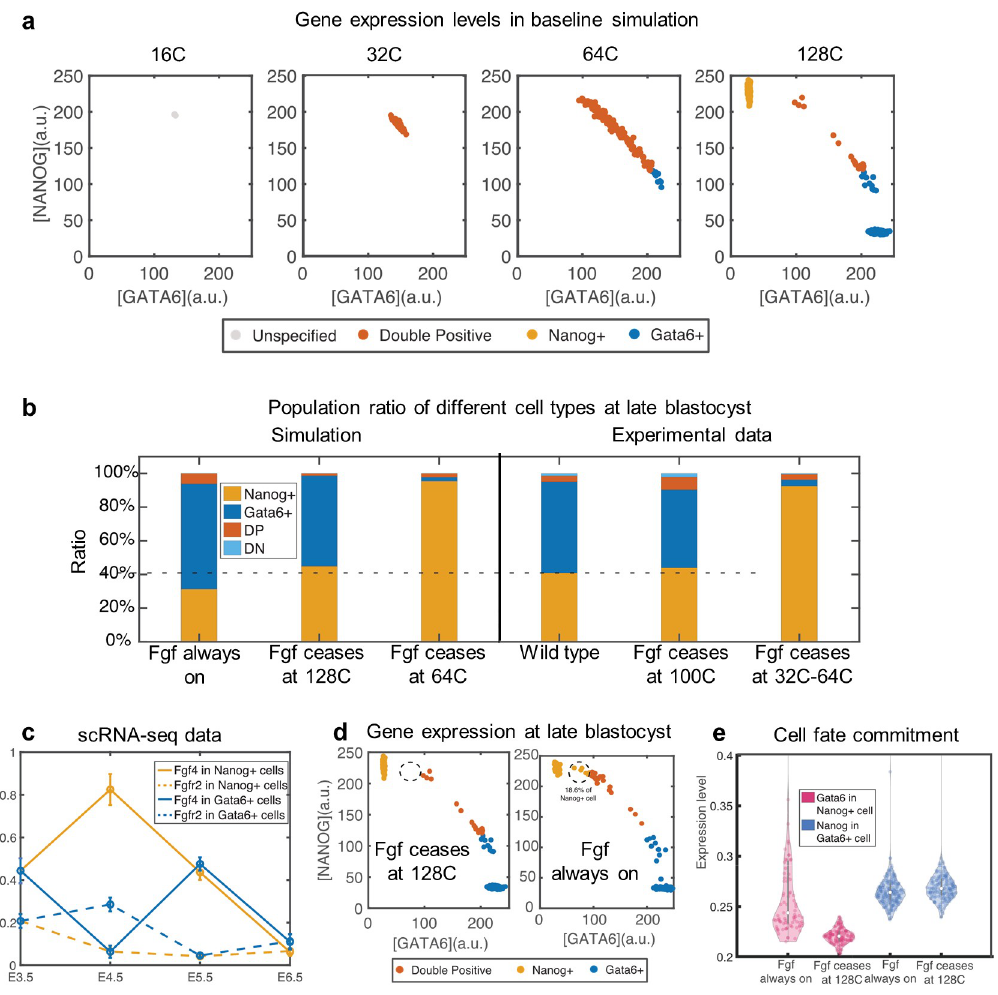
Fig 4. Nanog/Gata6 pattern for different Fgf4 ceasing time. (a) Single cell gene expression level in different cell stages in baseline simulation. (b) Cell number percentage of DP/Nanog+/Gata6+/DN cells at different 128C (simulation)/ 100C-150C (experiment) stages with different Fgf ceasing time in simulations and experiments. The horizontal dashed line shows the percentage of Nanog+ cells in wild type experiment. (c) Fgf4/Fgfr2 expression levels (log1p transformed) in Nanog+/Gata6+ cells in different cell stages from scRNA-seq data. The vertical bar shows the standard deviation. T-tests were used to compare between Nanog+ and Gata6+ cells the Fgf4 or Fgfr2 expression levels from E4.5 to E6.5. The (t-statistic, two-tailed p-value) for Fgf4 at E4.5, E5.5, and E6.5 are (11.75, < 1e-16), (-0.80, 0.43), and (-1.29, 0.20), respectively; and for Fgfr2 at E4.5, E5.5, and E6.5 are (-3.83, 2.2e-4), (-0.27, 0.78), and (-1.37, 0.17), respectively. (d) Gene expression level of Nanog and Gata6 at 128 cell stage if Fgf ceases at 128C and if Fgf is always on. (e) Violin plot of Gata6 level of Nanog+ cell (red) and Nanog level of Gata6+ cell (blue) for simulation where Fgf4 is always on and simulation where Fgf4 ceases at 128 cell stage. The hollow circle shows the median. The t-statistic and two-tailed p-value are 7.44 and 1.7e-12 between the first two columns, and -0.54 and 0.59 between the last two